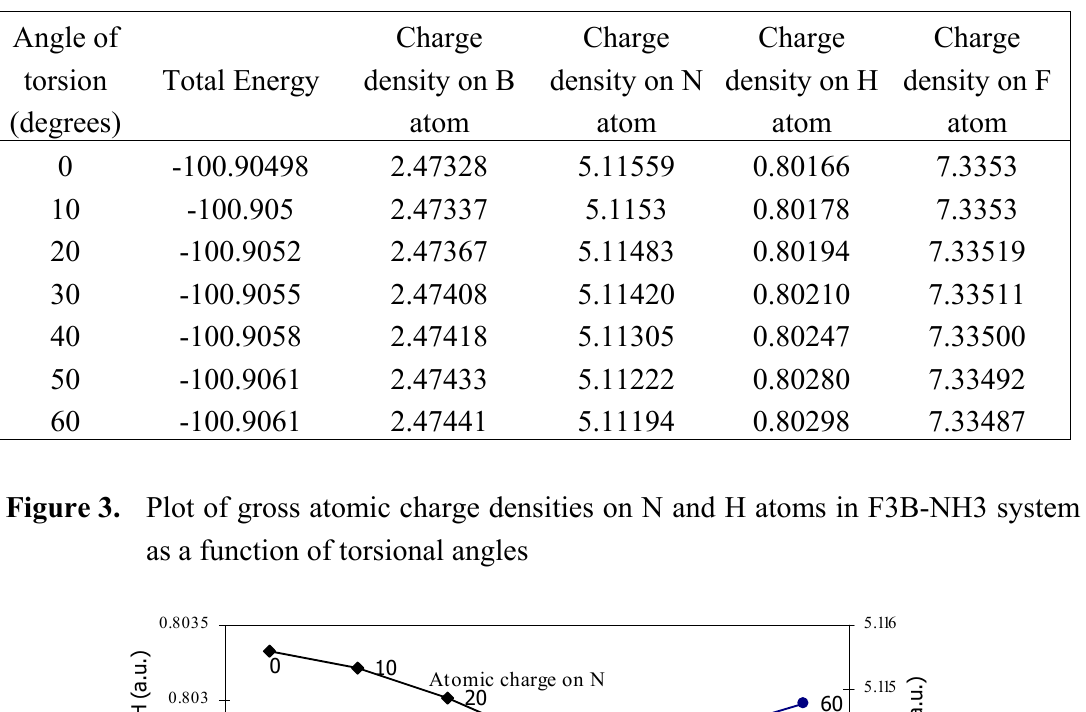
Table 5. Total energy and gross atomic charge density on different centers as a function of torsional angles (all in a.u.).